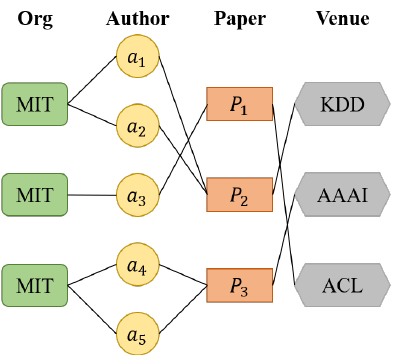
Figure 1. Heterogeneous graph network based on academic papers.